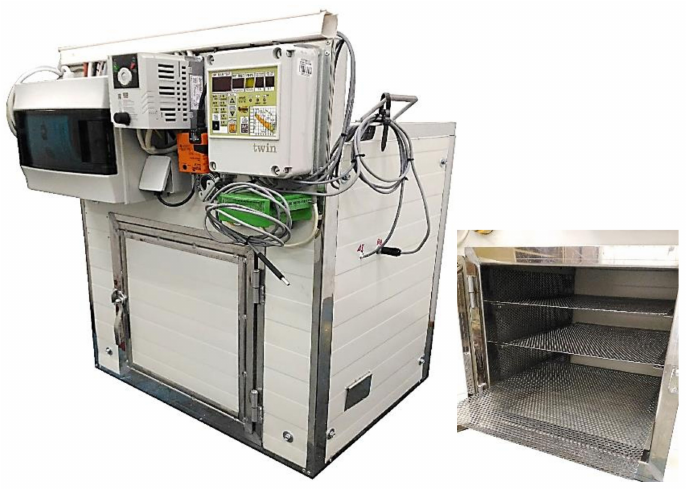
Figure 1. Laboratory-scale convective dyer and three-perforated tray drying